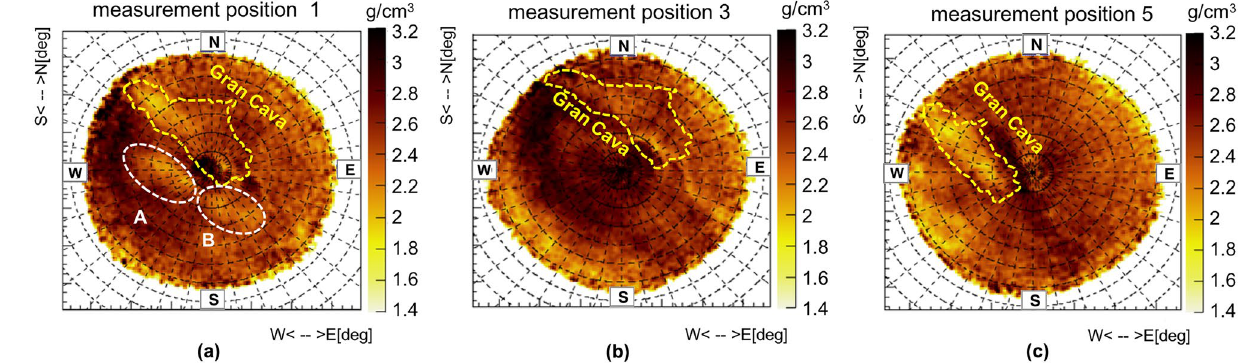
Figure 5. The two-dimensional average density angular distributions obtained from measurement positions 1, 3 and 5. The images are obtained with the ROOT